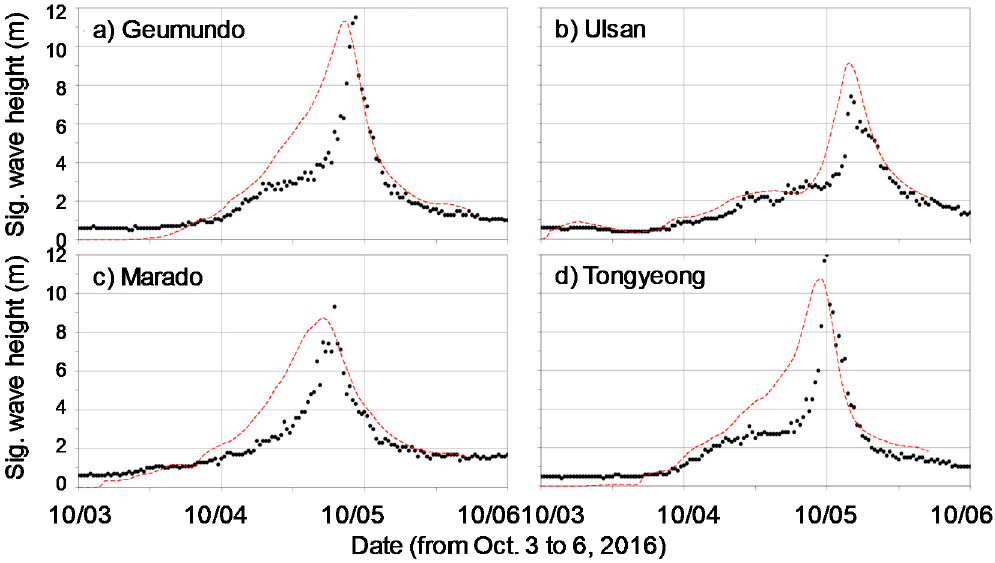
Figure 10. Verification of typhoon-induced wave by SWAN (black scatter: observed results; red dashed line: simulated results).